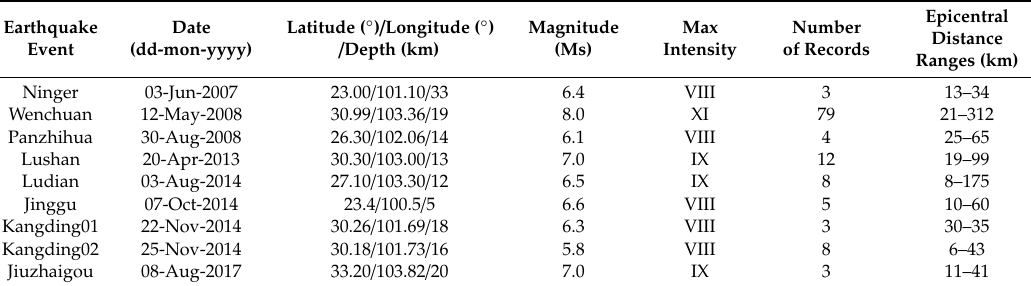
Figure 1. Distribution of earthquakes and strong motion stations. Table 1. Earthquake events in the Sichuan–Yunnan